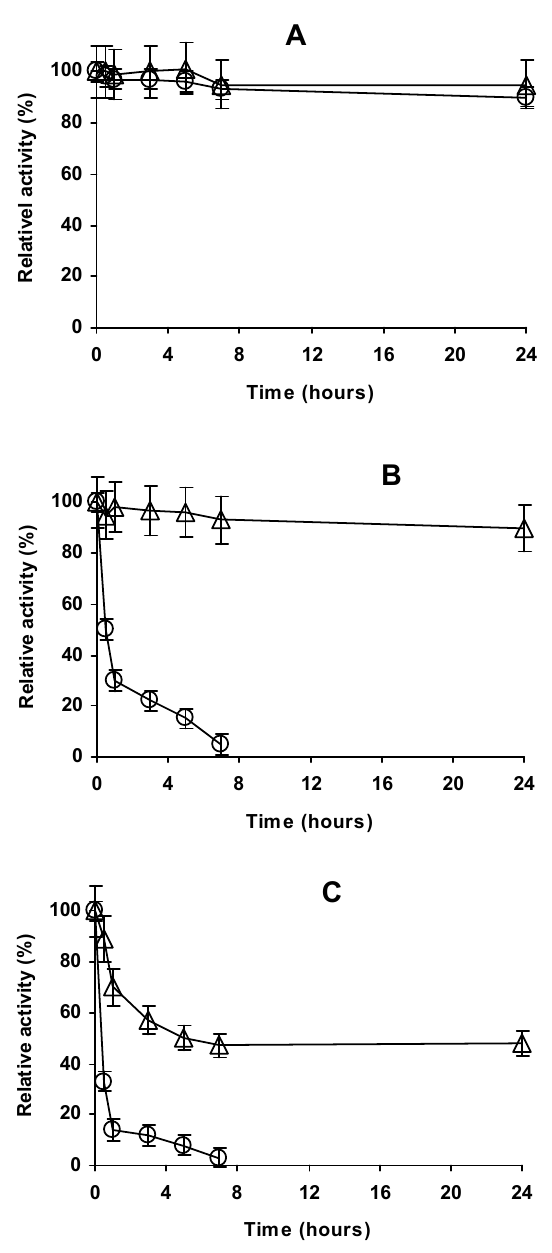
Figure 5. Effect of the pH value on the immobilization courses of β -gal on pre-activated MANAE-glutaraldehyde supports. The immobilization was performed at: ( A ) pH 5; ( B ) pH 7; or ( C ) pH 9 at 25 °C using 5 mM sodium acetate, sodium phosphate or sodium bicarbonate, respectively, as described in Methods Section. A support having 60 μ mol MANAE groups/g of support was utilized. All experiments were performed in triplicate and the values are given as mean value ± the experimental error. Other specifications are described in Methods Section. Triangles: immobilization suspension; and Circles: immobilization supernatant. Incubation of the immobilized enzymes at pH 7 or 9 after 24 h in 500 mM NaCl/25 mM sodium phosphate produced the full release of the enzyme immobilized on MANAE-agarose [37,38], but all enzyme molecules remained immobilized on the glutaraldehyde preparations, showing the success of getting a covalent